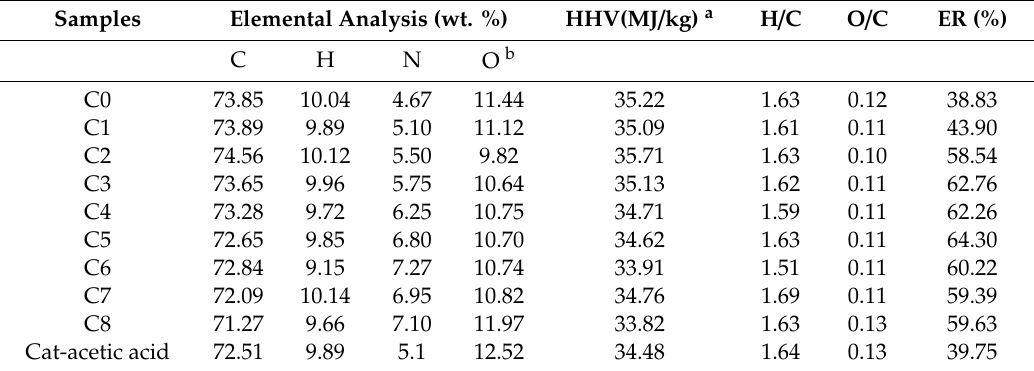
Table 5. Elemental Composition, O / C and H / C Ratios, and Energy Recovery along with consecutive recycling of the aqueous